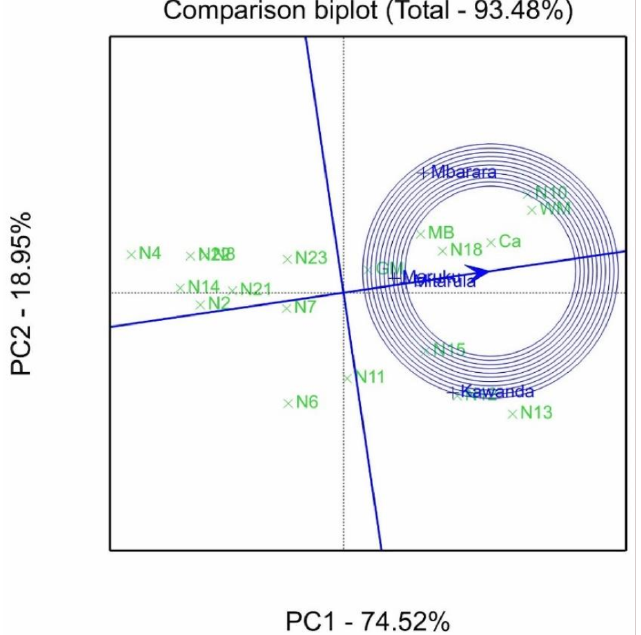
Figure 5. Discriminativeness and representativeness of the four testing sites based on the genotype x environment data of 19 banana cultivars (Matooke hybrids N—NARITA and banana varieties; MB—Mbwazirume, WM—Williams, Ca—Cachaco, GM—Gros Michel). The area of the inner circle of the biplot represents an ideal test environment, and the environment plotted within this circle is the best for Matooke hybrids and banana varieties evaluation. The location with the longest vector from the average environment axis and furthest from the ideal environment indicates high discriminativeness but poor